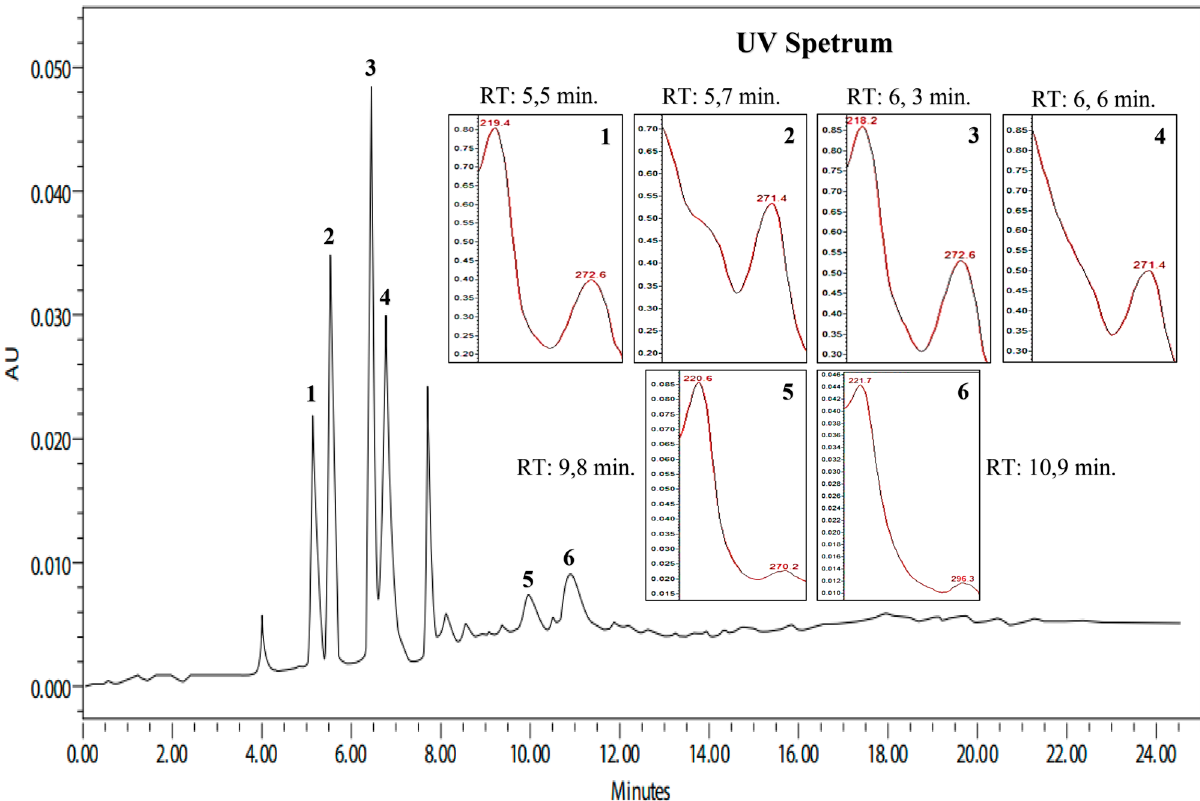
Figure 2. Chromatographic profile and UV spectra of the ethanolic extract of Aspidosperma nitidum . λ = 250– 400 nm.